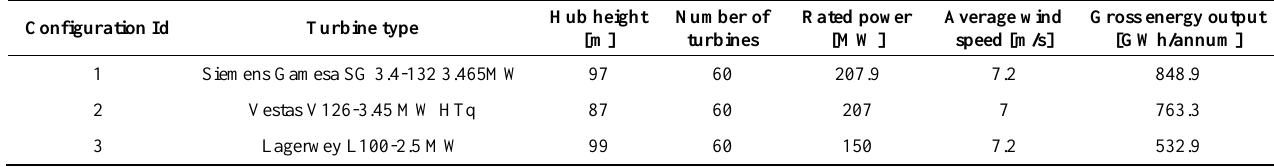
Table 4. Turbine layout configurations and gross